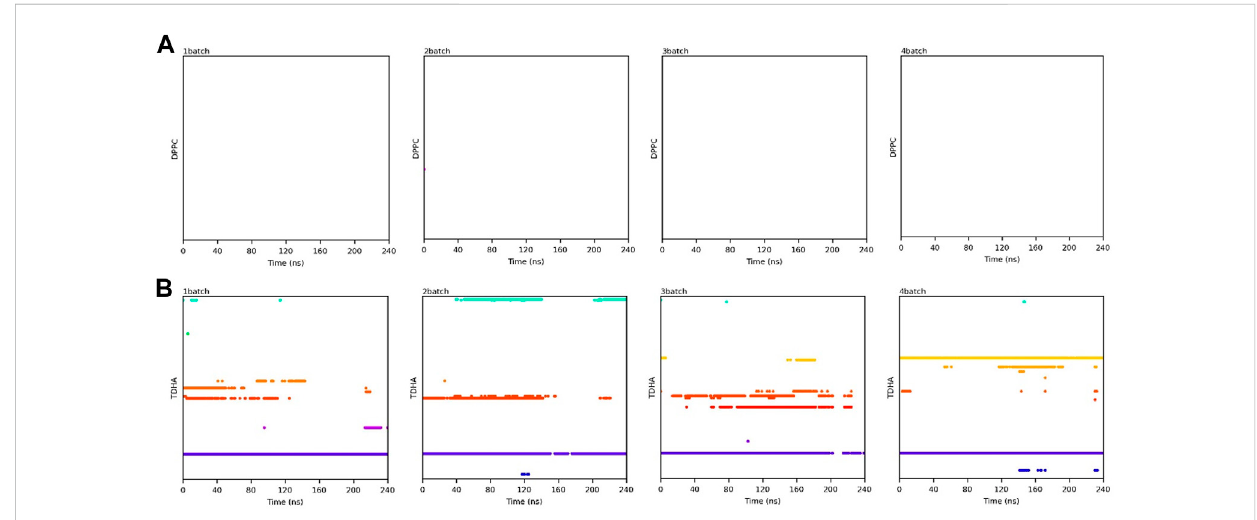
FIGURE 10 Binding time of the substrates (A) PC; (B) DHA-TAG in the active center of PLA1 in solvent-free system without water. Each color represents one substrate molecule. The length of the line with each color re fl ected the stability of the relevant complex; DPPC stands for PC and TDHA stands for DHA- TAG in the fi gure label.